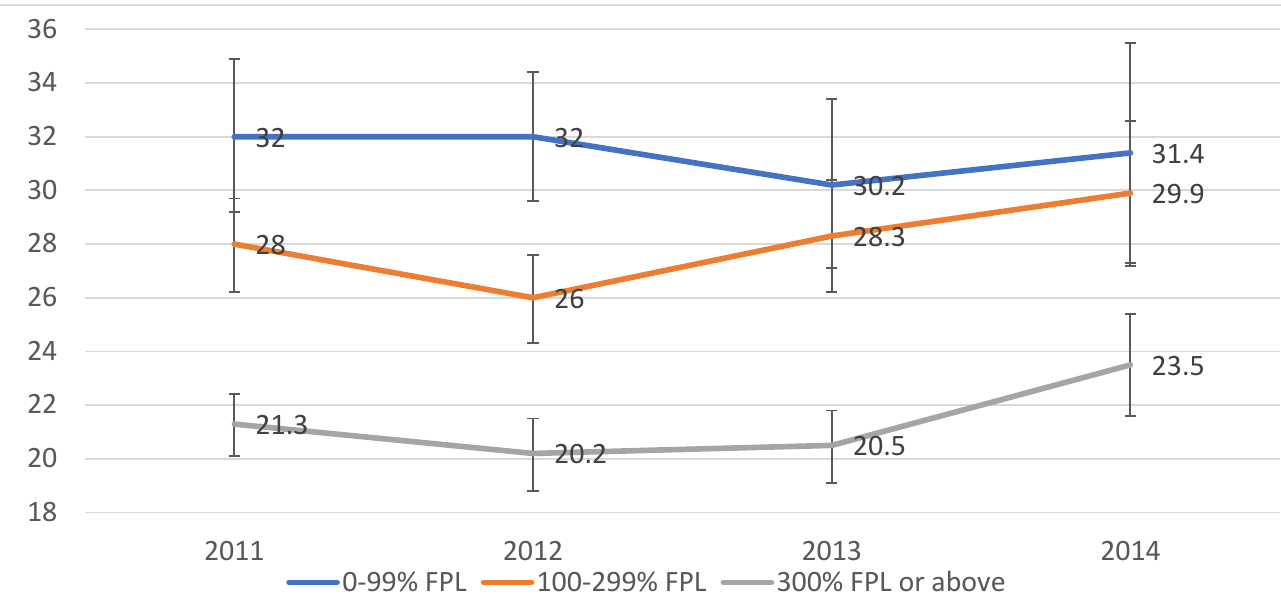
Figure 1. Obesity prevalence among adults by survey year and family income: California Health Interview Survey, 2011 – 2014. Note. FPL = federal poverty level. Survey weights were used in all analyses, and analyses were adjusted for the complex survey design. Obesity was defined as a body mass index of 30 or above.